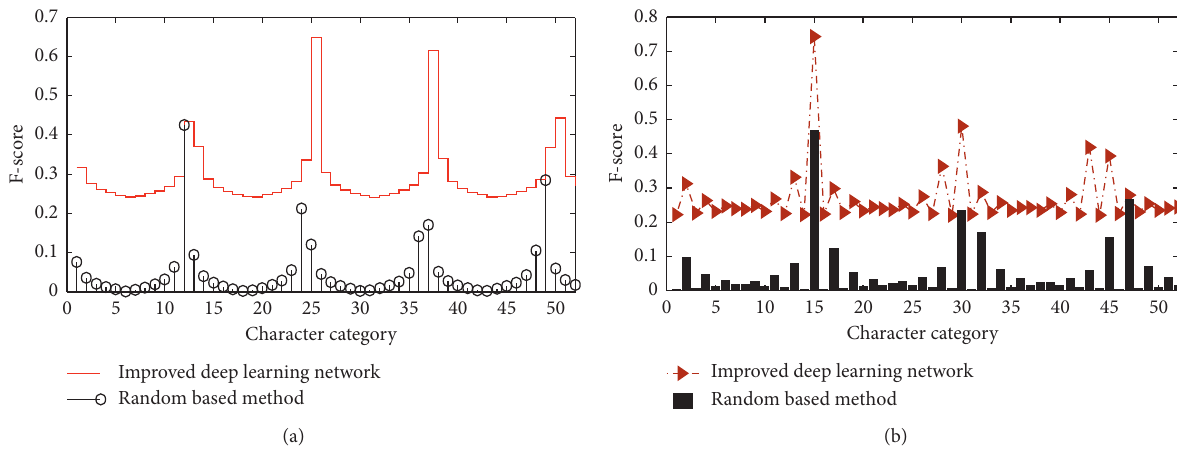
Figure 7: Experimental results of character detection in textual implication translation: (a) comparison of the method based on the improved deep learning network model and the method based on random on the Char 74k test set; (b) comparison of the method based on the improved deep learning network model and the method based on random on the ICDAR 2003 test